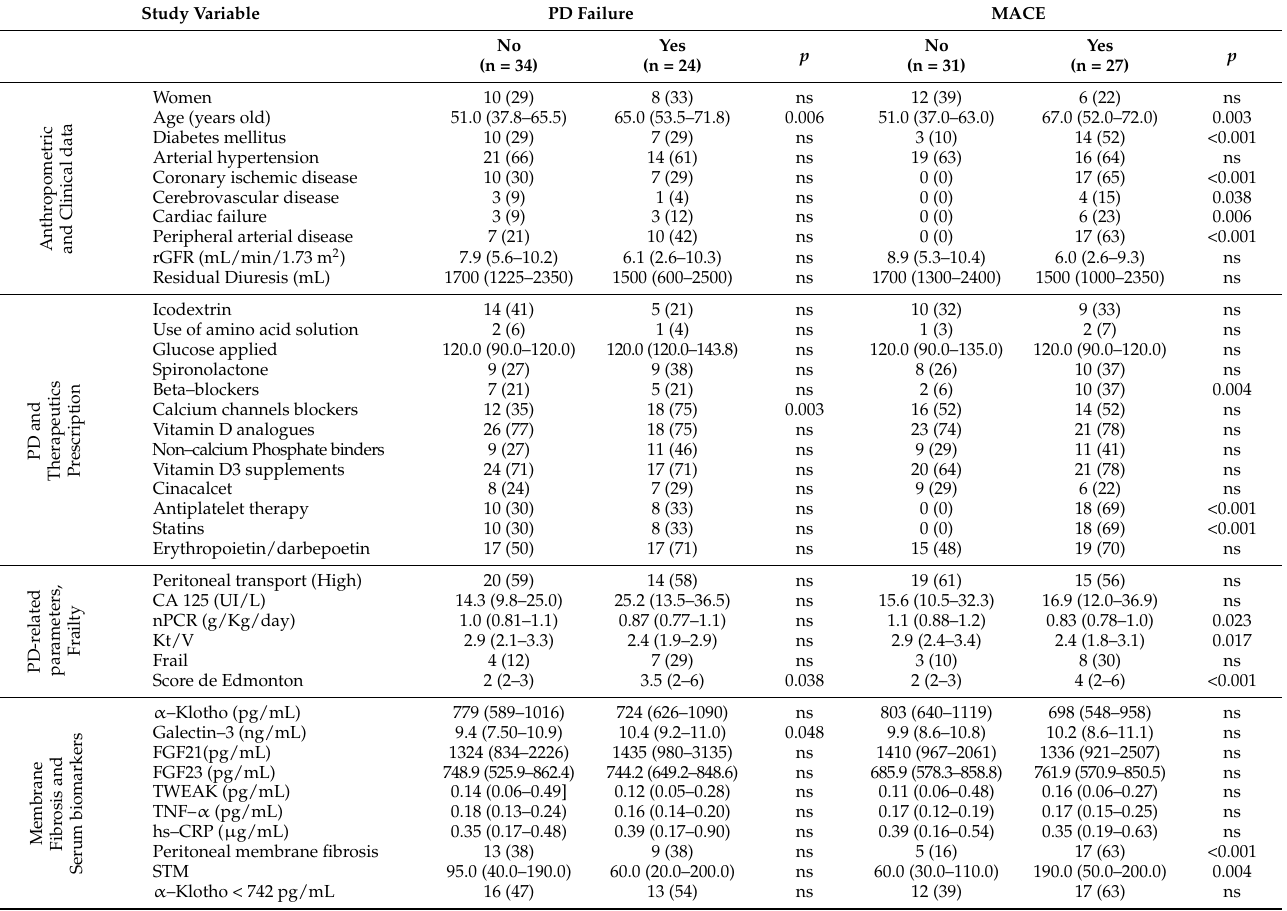
Table 2. Baseline variables according to technical failure or